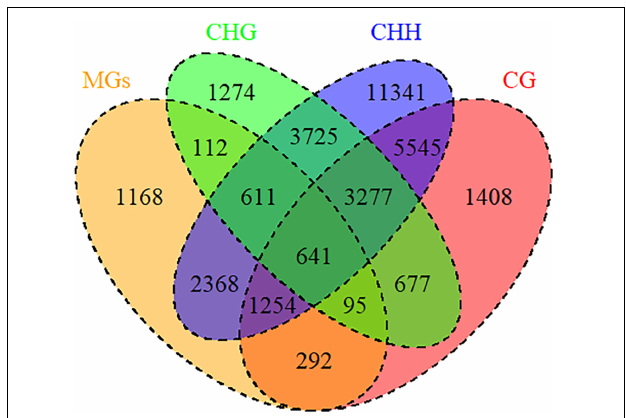
FIGURE 7 | DNA methylation regulated memory genes. Venn diagrams of memory genes and DNA methylation. MGs: memory genes (orange); DNA methylation types: CG (red), CHG (green), CHH